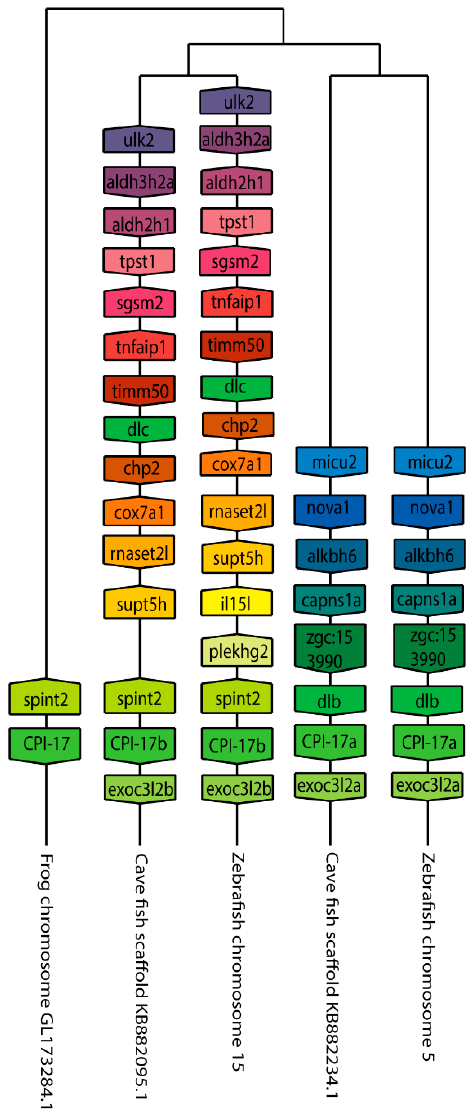
Figure 3. The genomic organization of the Cpi-17 ( ppp1r14a) paralogs in zebrafish. Genomicus was used to analyze Cpi-17 ( ppp1r14a) synteny between Danio rerio (Zebrafish) , and the most closely related sequenced relative, Astyanax mexicanus (Cavefish) . Xenopus laevis (African clawed frog) was used as an outgroup. Homologous genes are shown with matching coloration, and the gene direction on the chromosome is indicated by the direction of the boxed arrow. Species and chromosome numbers are noted.